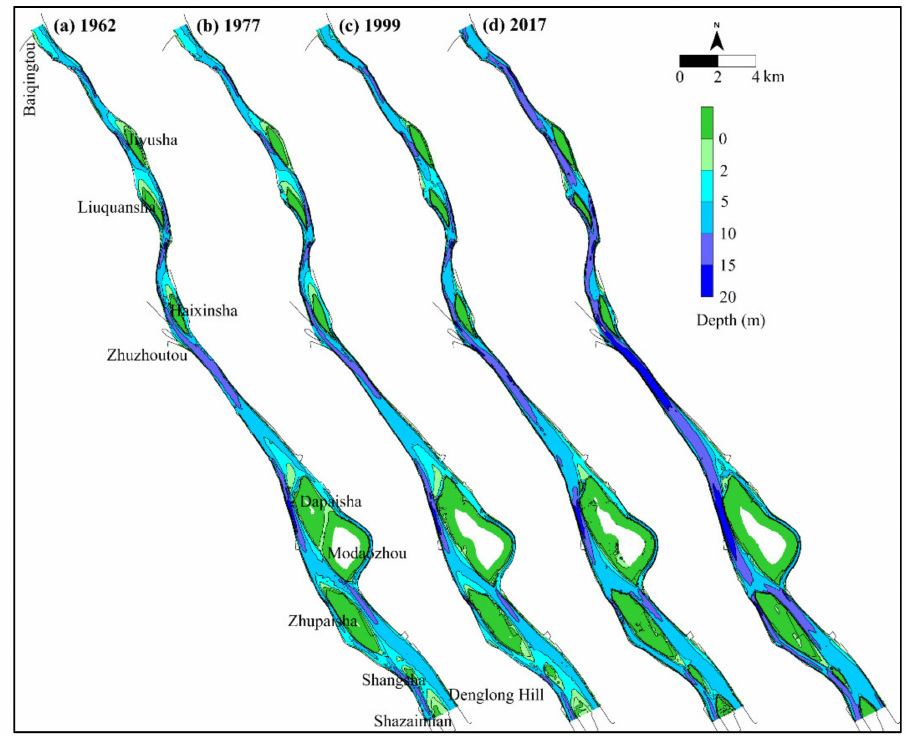
Figure 2. Bathymetry of the Modaomen Channel in ( a ) 1962, ( b )1977, ( c ) 1999, and ( d )